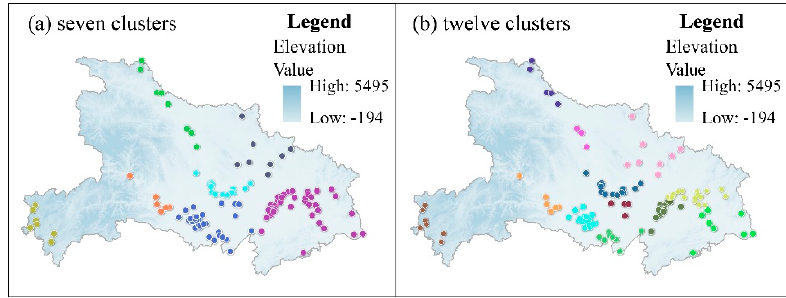
Figure 7. Cluster analysis of toponyms containing “Jiang”, ( a ) seven clusters; ( b ) twelve clusters.